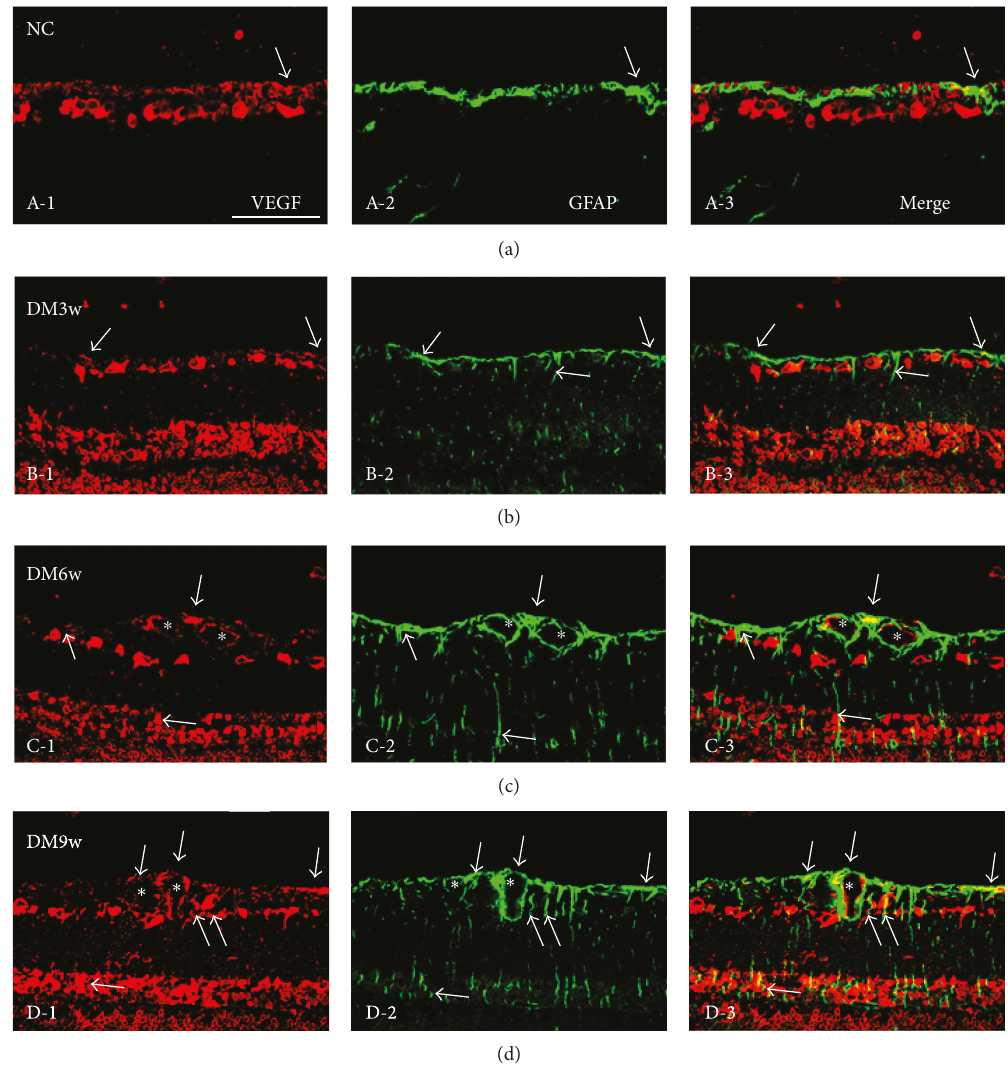
Figure 4: Representative photomicrographs of VEGF (red) and GFAP (green) double staining of the retina in the NC, DM3w, DM6w, and DM9w groups. VEGF immunoreactivity was localized in GFAP-labeled astrocytes (single arrow), blood vessels (asterisk), and Müller cells with their processes spanning across di ff erent retinal layers (double arrows). Bar=50 μ